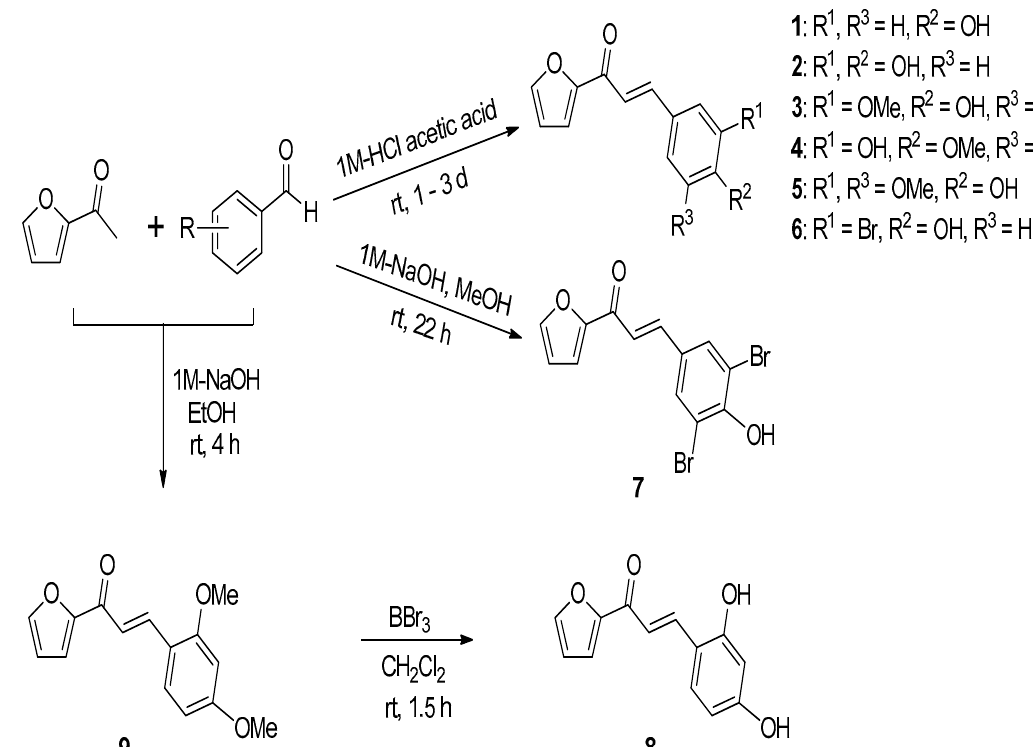
Table 1. Substitution patterns and mushroom tyrosinase inhibitory activities of ( E